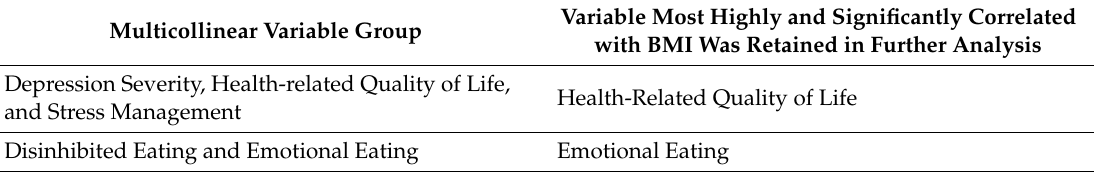
Table 2. Selection Rationale for Single Variable from Multicollinear Variable